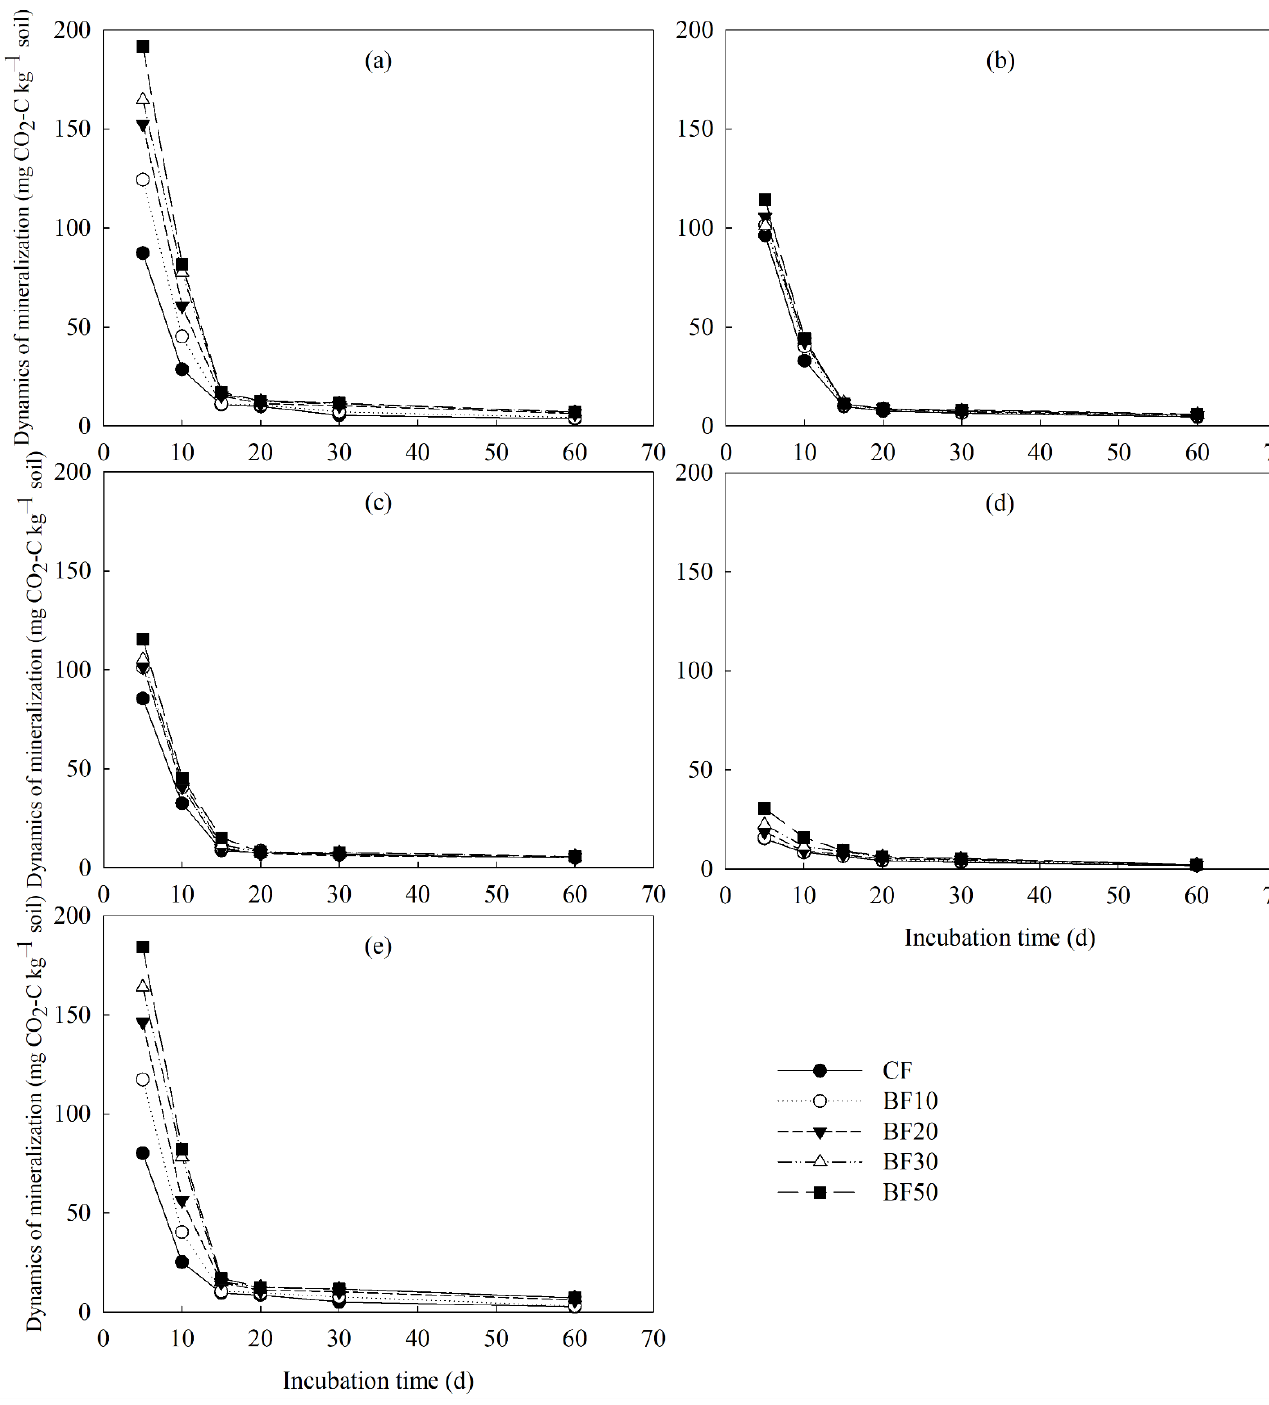
Figure 2. The dynamics of organic C of mineralization in >2 mm ( a ), 0.25 – 2 mm ( b ), 0.053 – 0.25 mm ( c ), <0.053 mm aggregate fractions ( d ) and bulk soil ( e ) for the five treatments. Values are means of three replicates. CF, BF10, BF20, BF30 and BF50 are defined as in Figure 1.